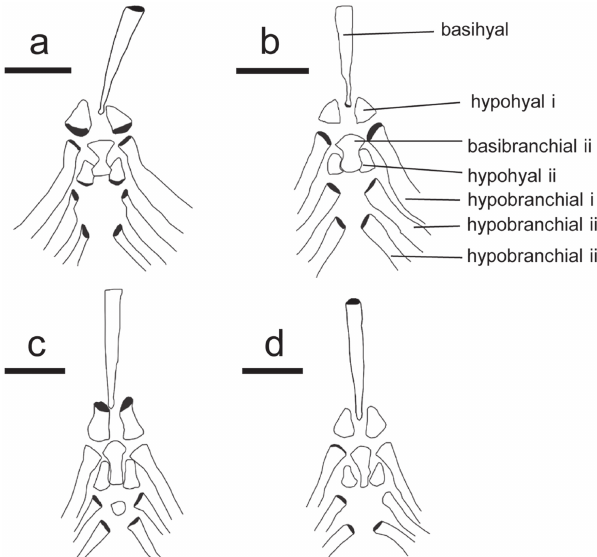
Fig. 3. Dorsal view of the brachial basket in four species of Sternarchella. a. Sternarchella patriciae (MUSM 45234). b. Sternarchella orinoco (USNM 228727). c. Sternarchella schotti (UF 116570). d. Sternarchella orthos (USNM 228871). Scale bar = 0.5 mm. Note differences